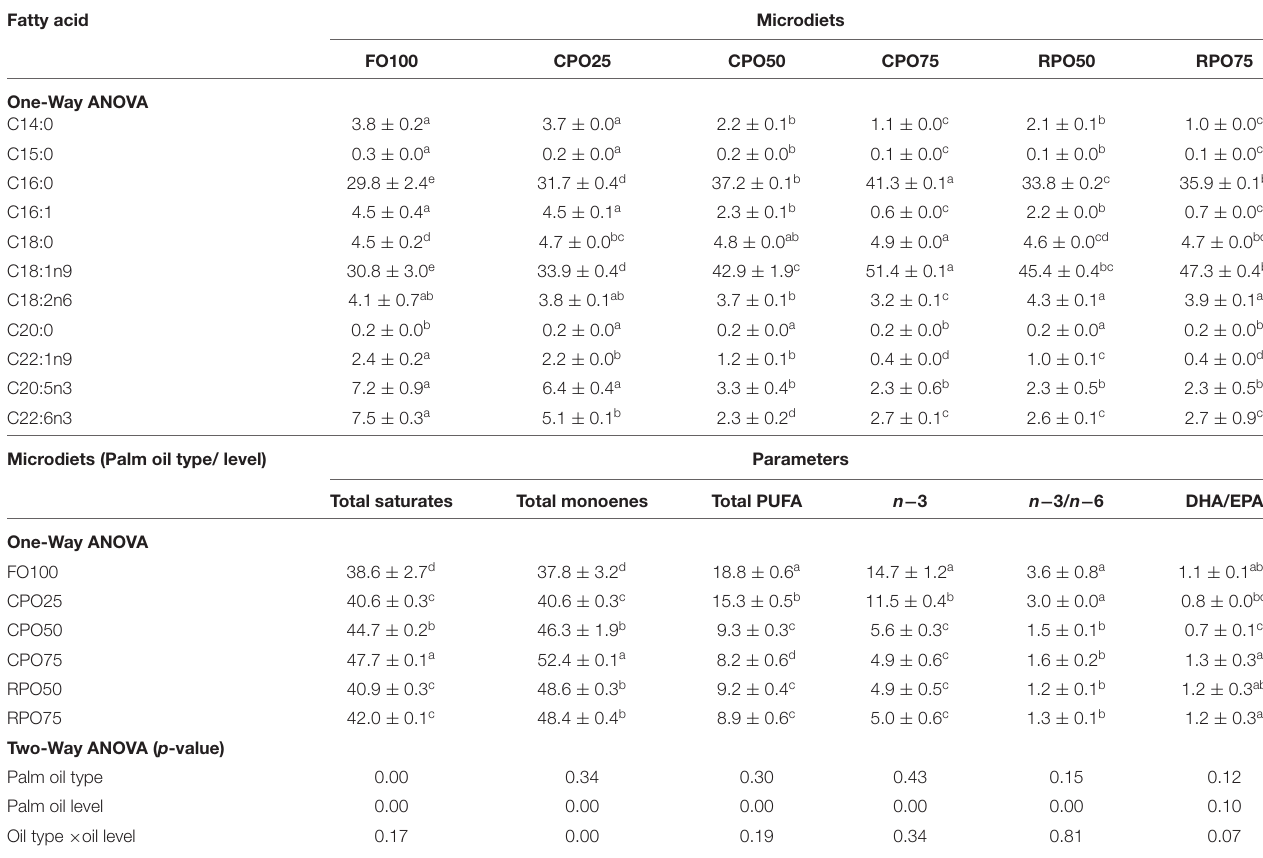
TABLE 5 | Fatty acid composition (percentage of total fatty acids) in different microdiets. Fatty